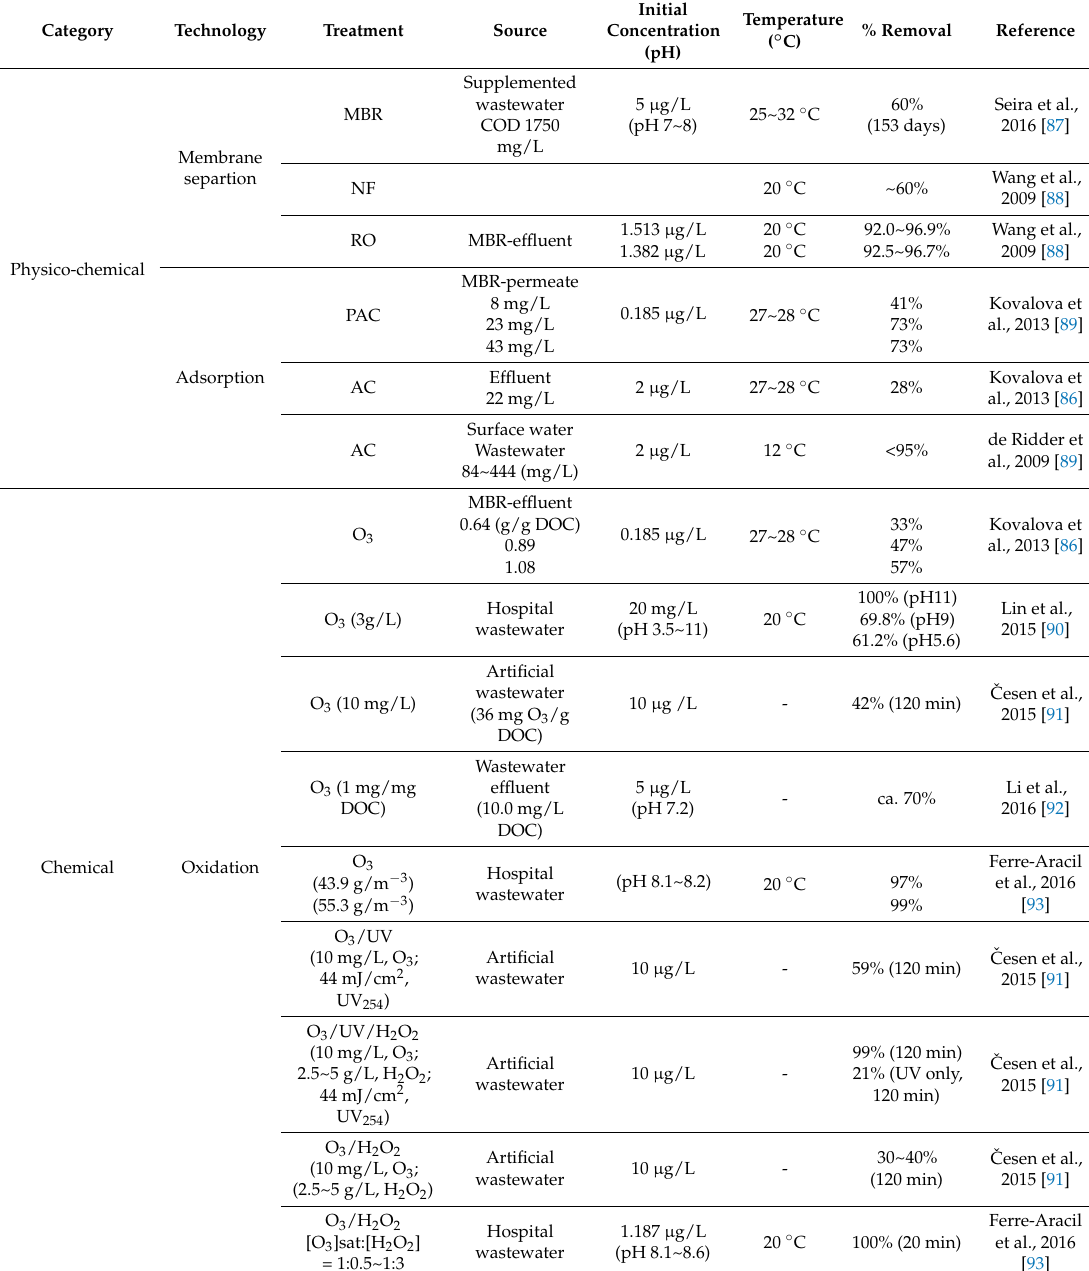
Table 7. Removal efficiency of cyclophosphamide (CP) from wastewater